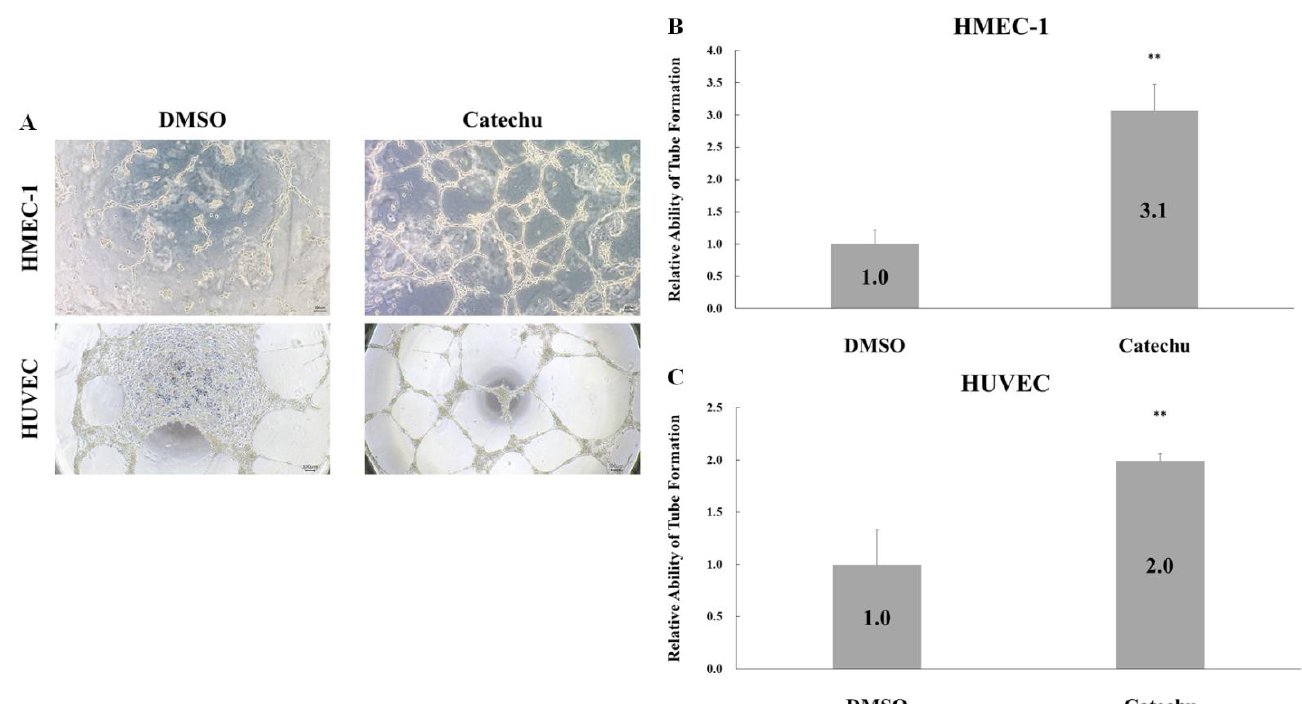
Figure 3. Effect of catechu extracts on the tube and network formation of HMEC-1 and HUVEC cells. ( A ) Representative photos of the tube formation assay at 24 h. HMEC-1 and HUVEC cells were treated with 0.8 ng/mL and 1.0 ng/mL crude catechu extracts, respectively. The network formation was quantified by the mesh number formation for ( B ) HMEC-1 and ( C ) HUVEC cells. Data are presented as means ± SD in three independent experiments. The p -value was calculated versus the control using one-tailed test analysis; p < 0.005 is denoted as **.